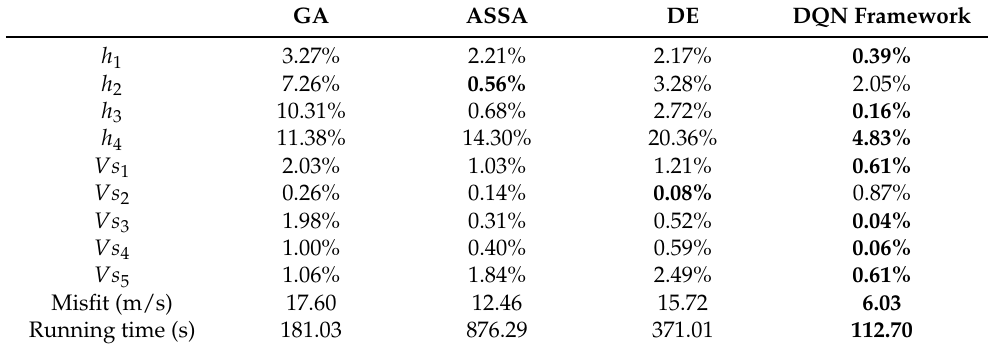
to the lowest relative error, misfit value, or running time over each row. Table 6. Performance analysis for Case